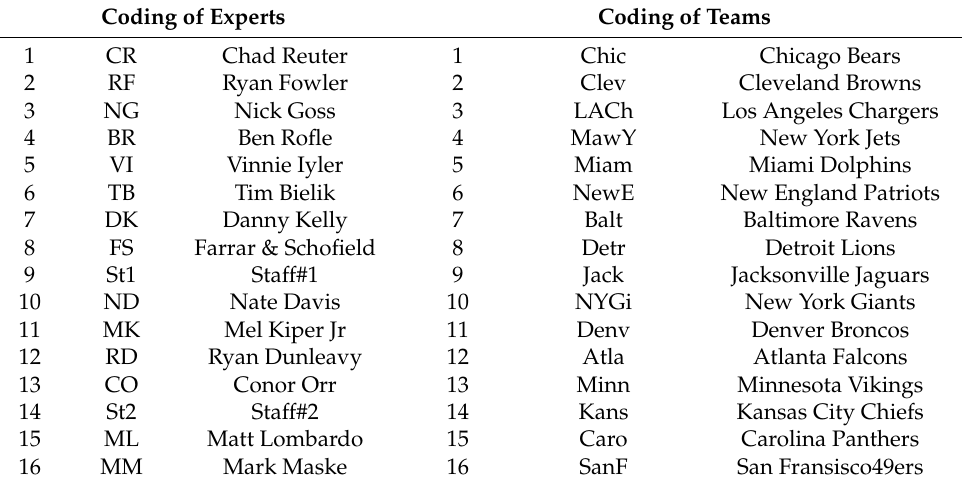
Table 1. Coding of experts and